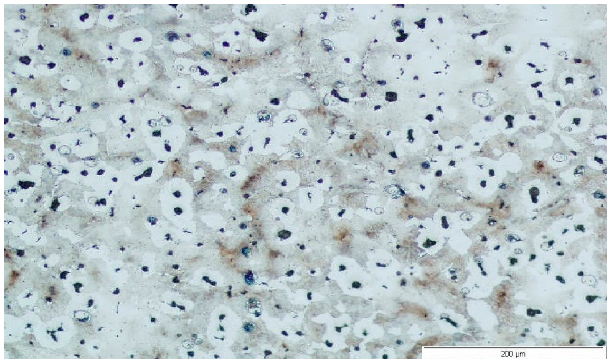
Figure 1. BM microstructure (magnification 200×).